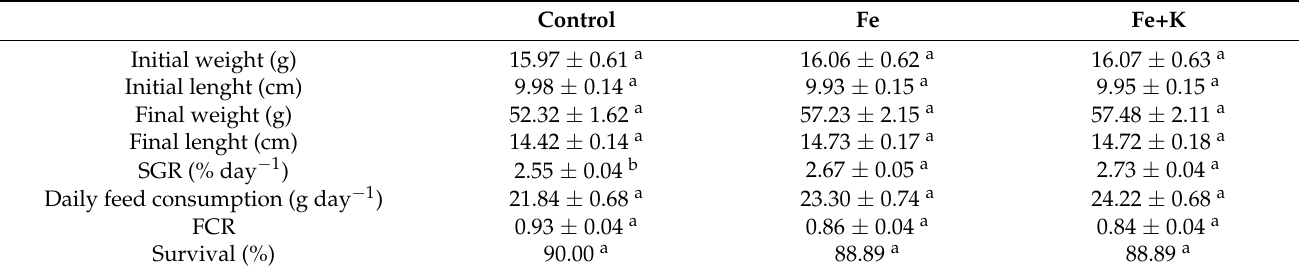
Table 3. Growth parameters of red tilapia (Mean ± SEM, n = 90). Different superscripts in a row denote statistically significant differences among treatments ( p <